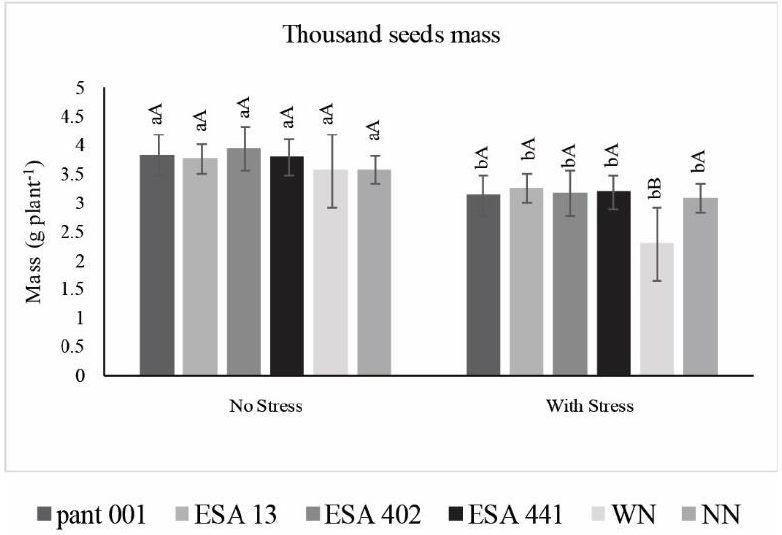
Figure 6. Interaction between water regime x treatments, with inoculants based on bacilli, with significance at p ≤ 0.05 Tukey test for the mass of one thousand seeds of sesame cultivars (BRS Seda and BRS Anah í ), under water restriction. Water regimen: no stress and with stress. WN-with nitrogen and NN-no nitrogen. Lowercase letters compare water regime; capital letters compare treatments within the water regime.